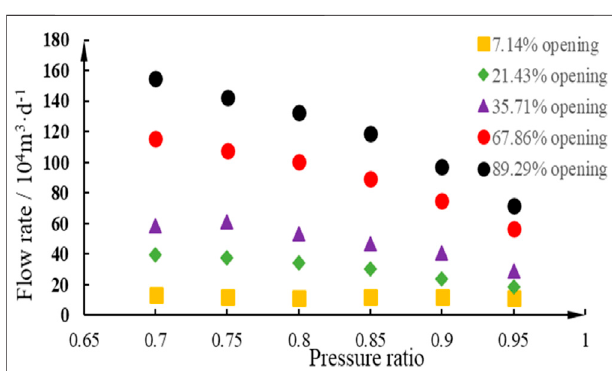
FIGURE 9 | Peak velocity curve at valve hole under different pre fi lling pressures. FIGURE 10 | Diagram of fl ow rate and upstream and downstream pressure ratio through the throttling valve in different opening degrees.